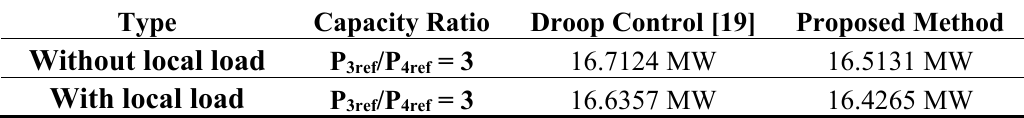
Table 5. Copper loss as outage of